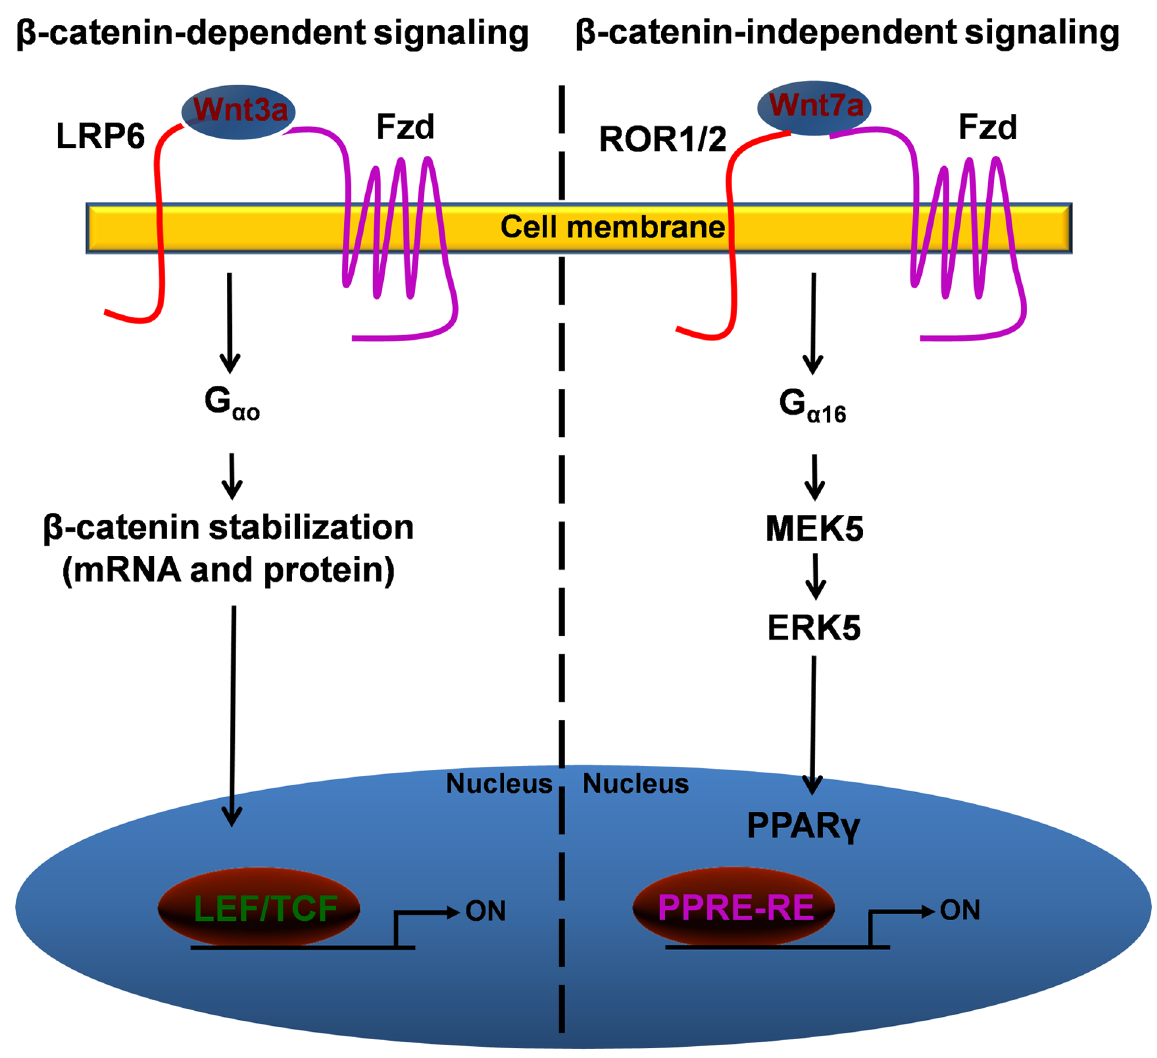
Figure 7. Schematic representation of differential utilization of co-receptors and G-proteins for b -catenin-dependent and b -catenin- independent signaling pathways. Based on our current understanding of Wnt-sensitive pathways, we propose that Wnt binding to Fzd and co- receptor LRP5/6, and mediated by G a o , leads to activation of b -catenin-dependent gene transcription. While, Wnt binding to Fzd and co-receptor ROR1/2, and mediated by G a 16 , leads to the activation of b -catenin-independent signaling pathway, mainly via activation of ERK5 and PPAR c